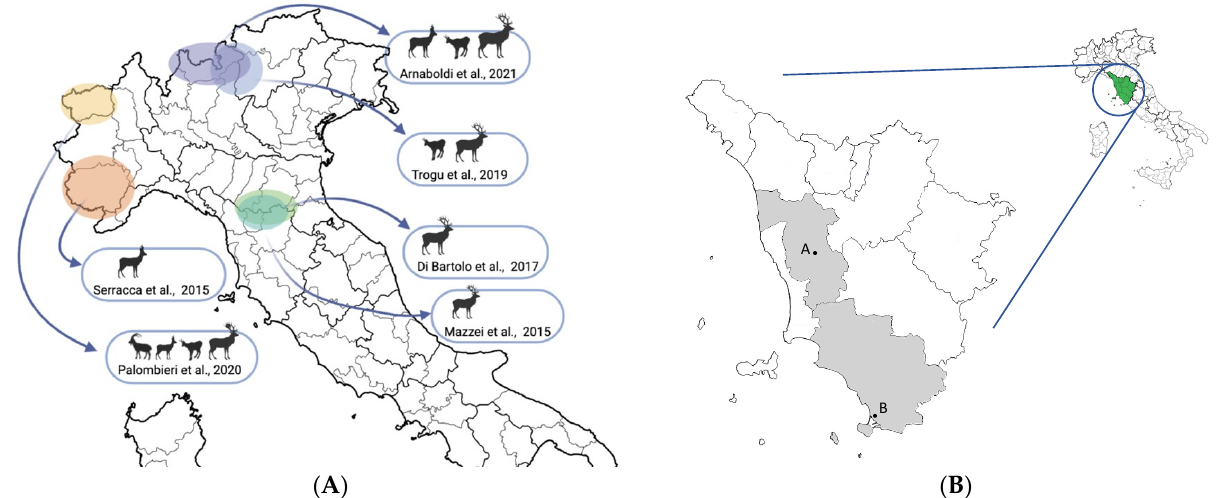
Figure 1. ( A ) Map of Northern and Central Italy with the geographical areas in which previous studies were conducted. No studies are reported in deer populations from Southern Italy. The references and the species included in each study are provided [22,24–28]. Created with BioRender.com (accessed on 10 February 2022); ( B ) Map of Tuscany with the two sampled areas in this study (Pisa and Grosseto provinces). A = Lajatico (PI), B = Orbetello (GR).